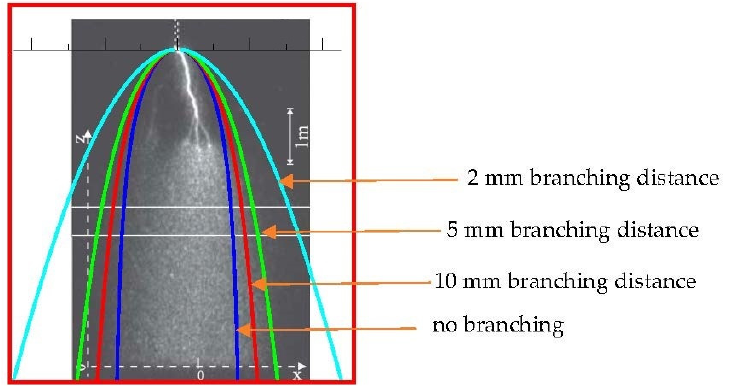
Figure 5. Streamer region of rod-plane gaps of ( i ) 2-m gap excited by 2 MV and ( ii ) 10-m gap excited by 10 MV. The curve (1) corresponds to no streamer branching and curves (2), (3) and (4) correspond to streamer branching lengths of 10 mm, 5 mm and 2 mm, respectively. The radius of the rod is 2 cm.